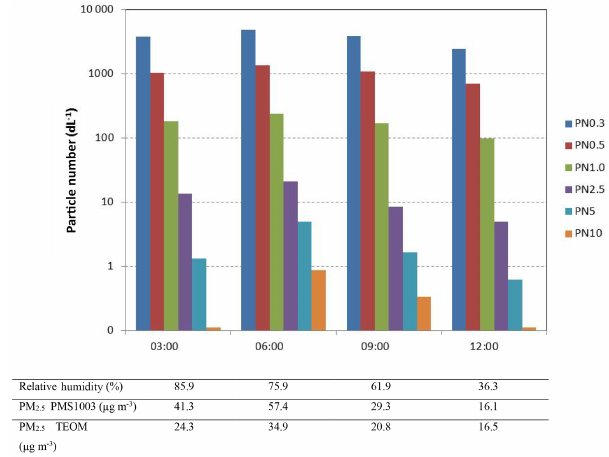
Figure 7. PNCs reported by the PMS1003 in the six size bins at three hourly intervals during a morning with fog (30 July). Fog was observed between 03:00 and 06:30. The table under the figure gives additional information at the respective